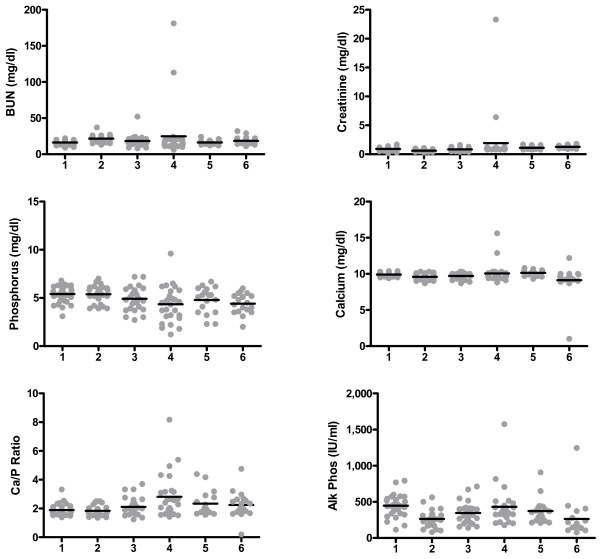
Alterations in serum chemistry values at defined time points during the course of treatment and disease. Alterations in blood urea nitrogen, creatinine, phosphorus, calcium, the Ca/P ratio and alkaline phosphatase were plotted at critical time points (1 = baseline, 2 = initiation of ART, 3 = 2 weeks ART, 4 = 4 weeks ART, 5 = ART end, 6 = study end). Grey dots represent individual animals and black lines represent the mean.